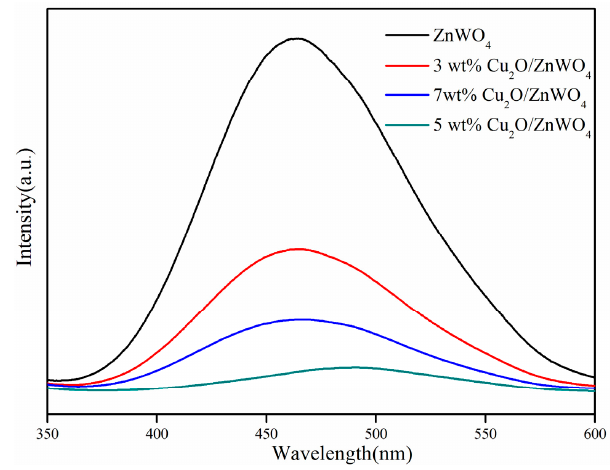
Figure 5. Photoluminescence (PL) spectra of ZnWO 4 and Cu 2 O/ZnWO 4 composites.